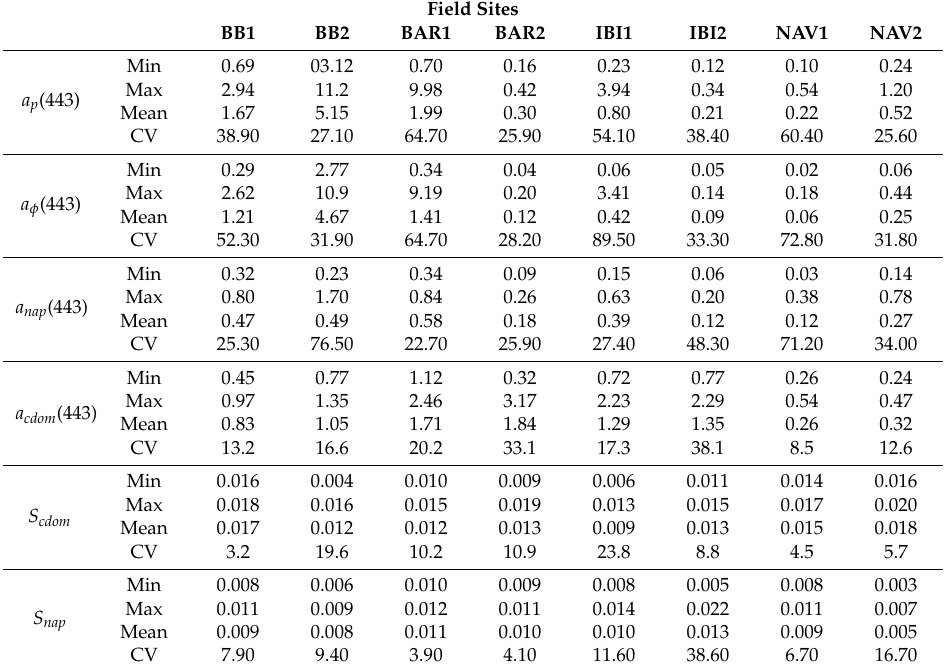
Table 2. Descriptive statistics of a p (443) in m − 1 , a φ (443), a nap (443), a cdom (443), non-algae particles (NAP) Slope ( S nap ), and colored dissolved organic matter (CDOM) Slope ( S cdom ). Where Max, Min, SD, and CV are the maximum, minimum, standard deviation, and coefficient of variation (in %). The exponential slope was obtained from CDOM within the 400–700 nm of